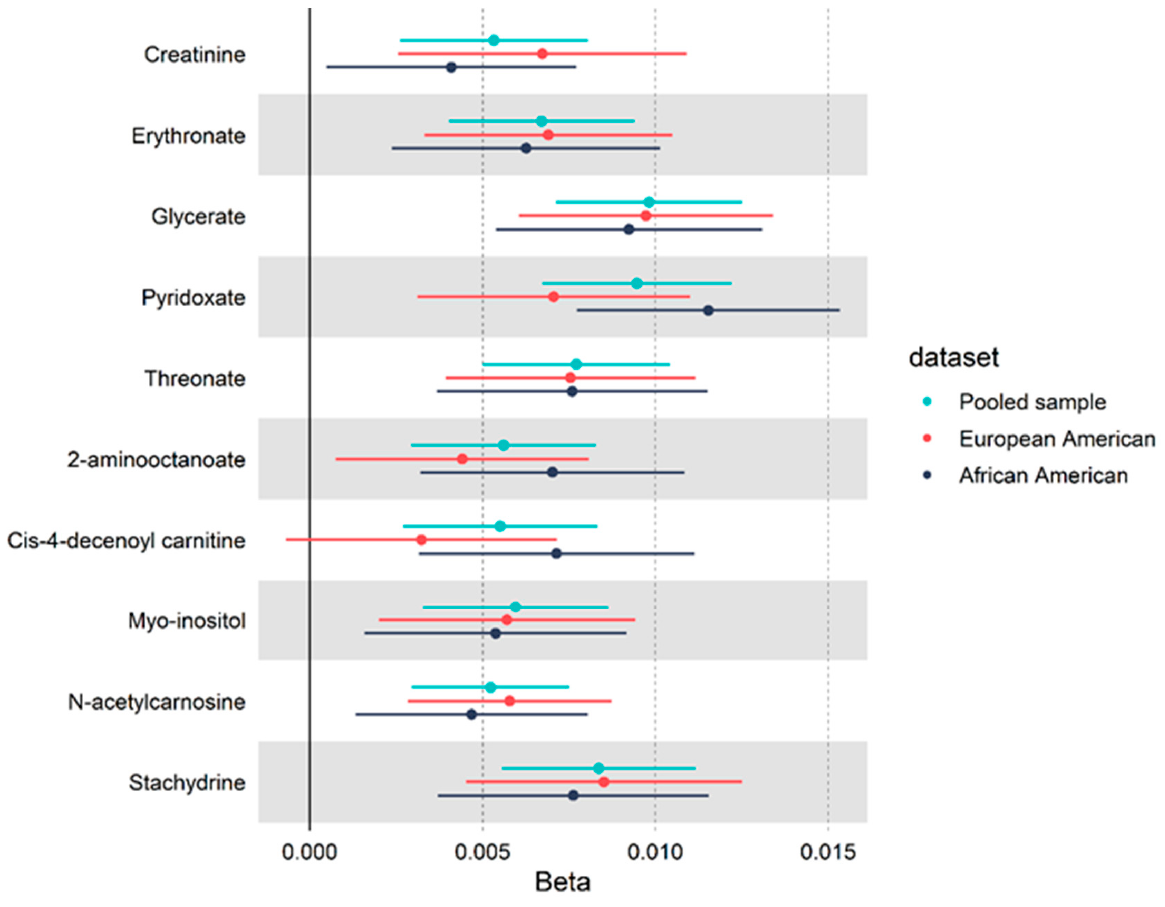
Figure 1. Fully adjusted association between moderate-to-vigorous-intensity leisure-time physical activity (MET · hr · wk − 1 ) and 10 metabolites in 3802 participants from the Atherosclerosis Risk in Communities study.